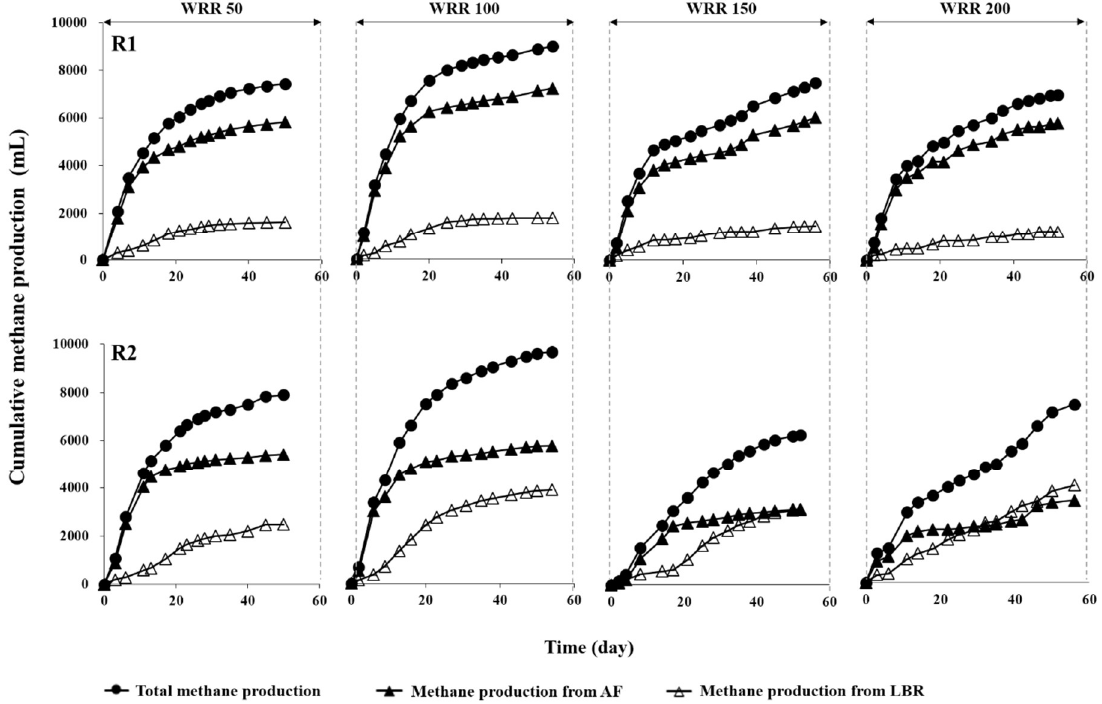
Figure 4. Cumulative methane production in R1 and R2 during batch experiment at each WRR (mL/d).